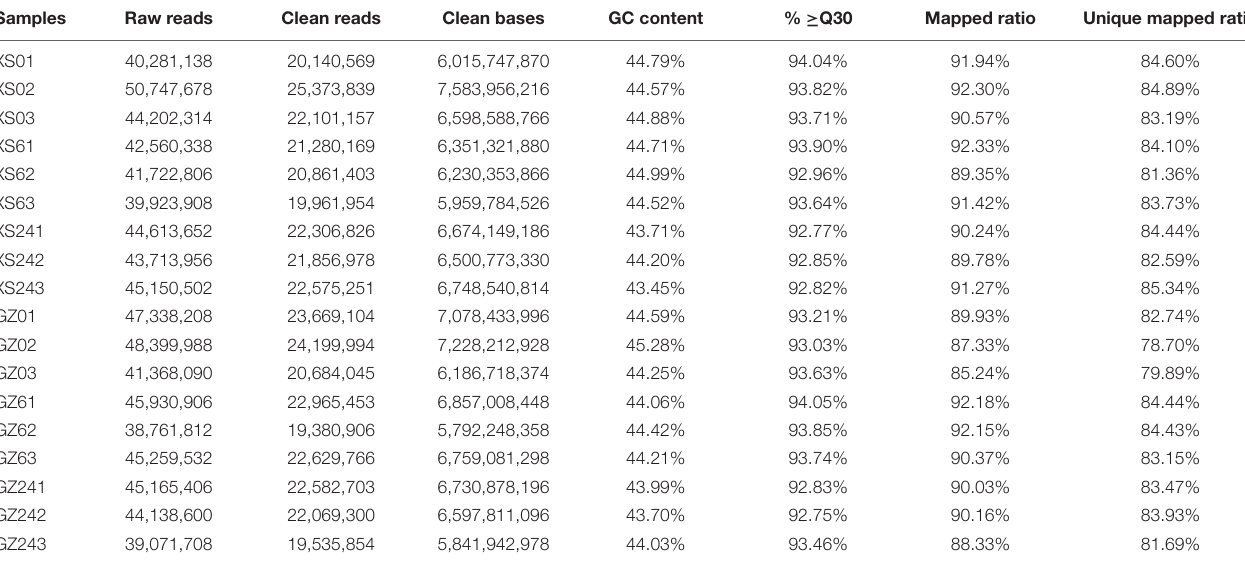
FIGURE 1 | (A) Morphological changes in the cold-sensitive (XS) and cold-tolerant (GZ) cultivars in response to cold stress. (B) Relative electrolyte conductivity (REC), (C) MDA content, (D) proline content, (E) SOD activity. “*” means P < 0.05 between treatment and control; “**” means P < 0.01 between treatment and control. TABLE 1 | Summary of the RNA-seq data collected from cold-sensitive cultivar XS and cold-tolerant cultivar GZ.